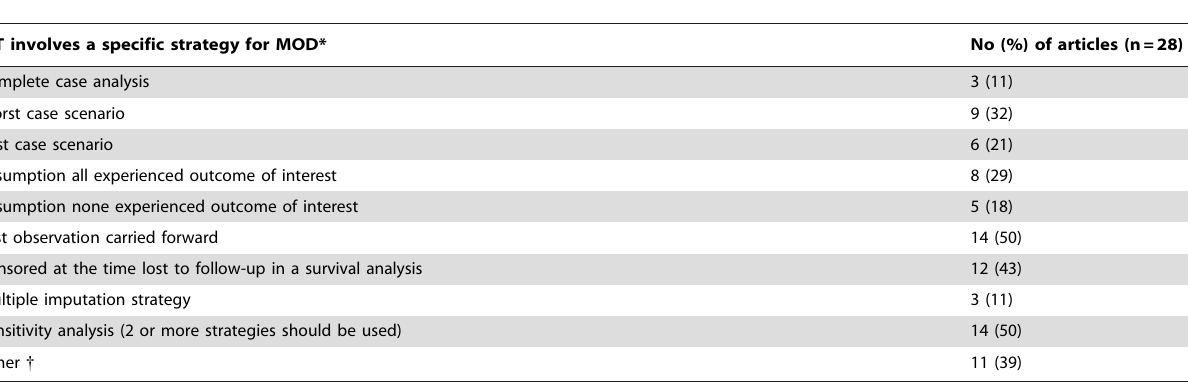
Table 2. Strategies to deal with missing outcome data (MOD) under intention to treat